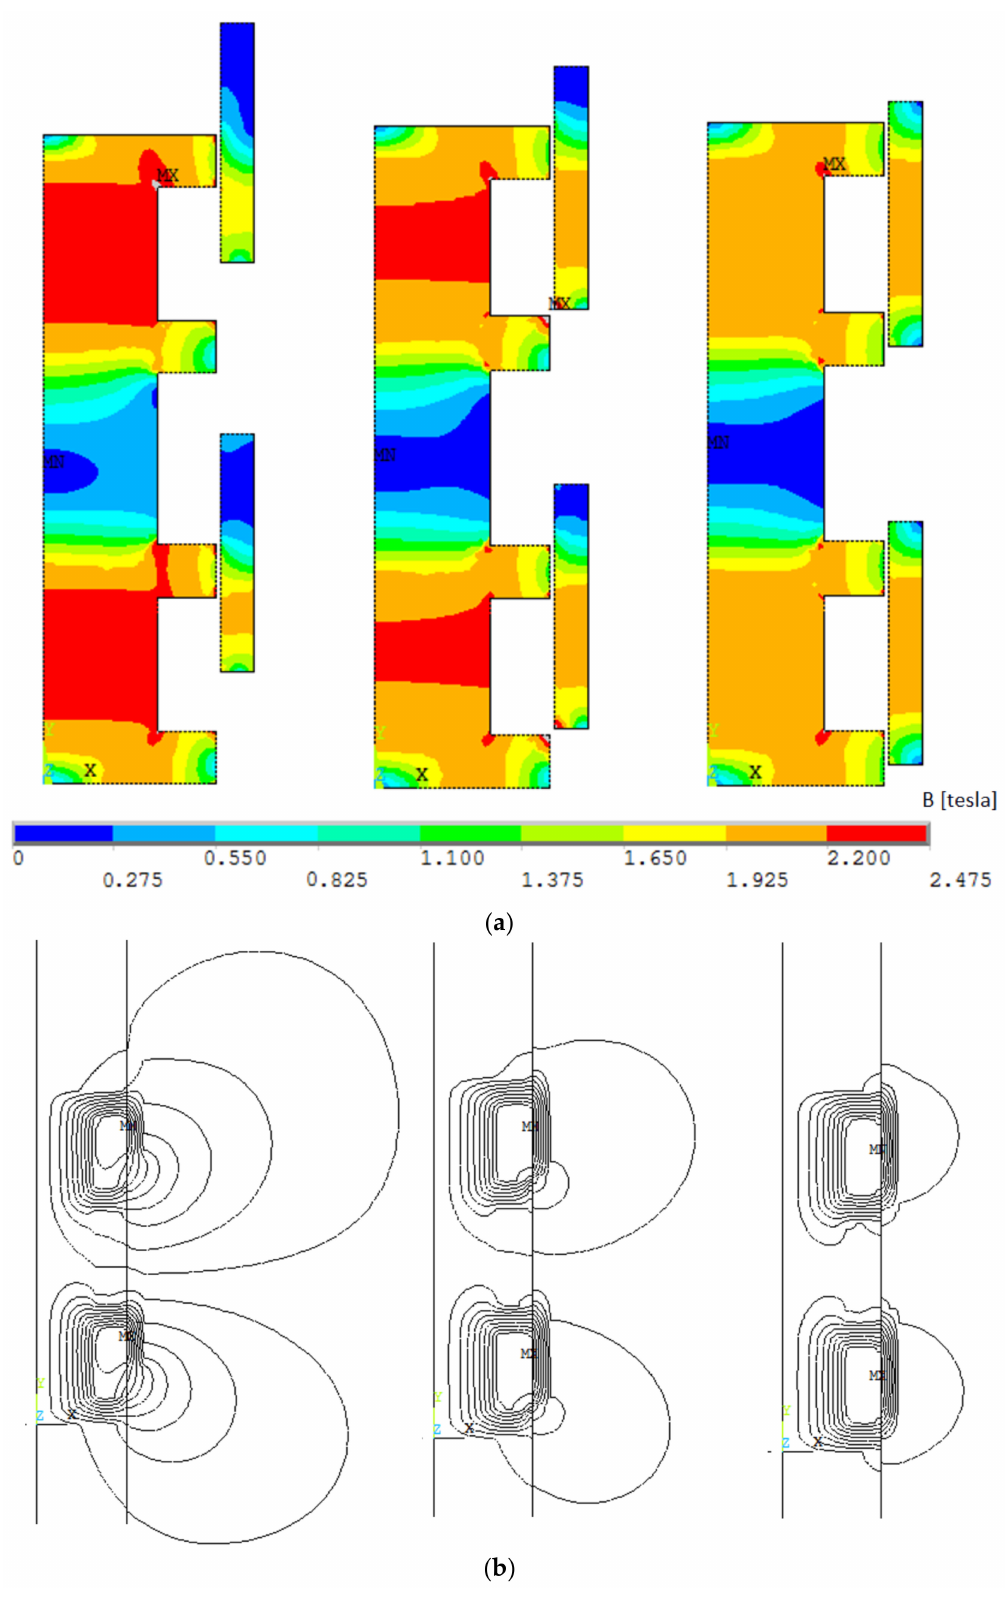
Figure 23. Magnetic field ( a ) and magnetic field lines ( b ) for hammer displacement (from the left): 1 mm, 2.5 mm and 4 mm—Variant